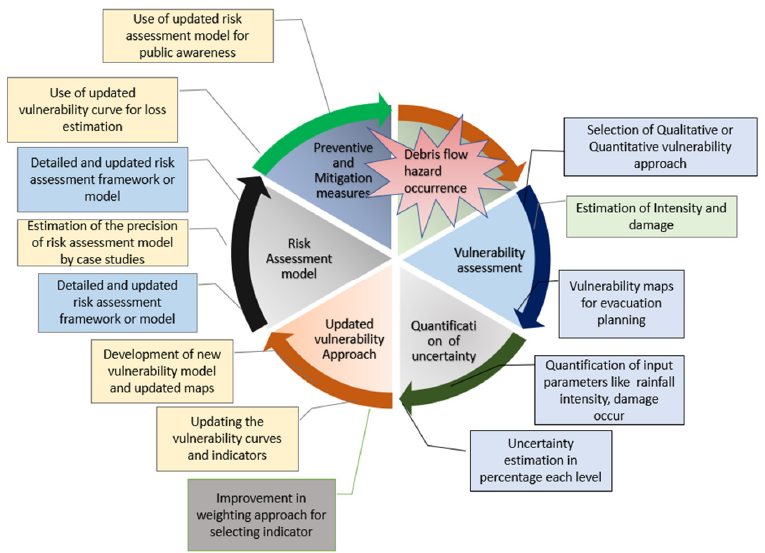
Figure 10. Risk management system showing various steps of analysis (reproduced and updated from [27]).